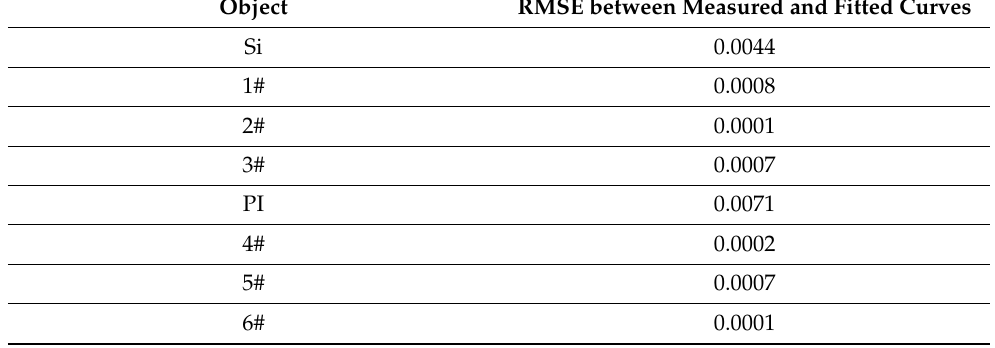
Figure 12. Measured spectral absorption curves of various substrates and nanoaggregate samples. ( a ) Measured spectral absorption curves of Si and PI substrates. ( b ) Measured spectral absorption curves of samples #1–3. ( c ) Measured spectral absorption curves of samples #4–6. Table 3. Statistics of measured error.